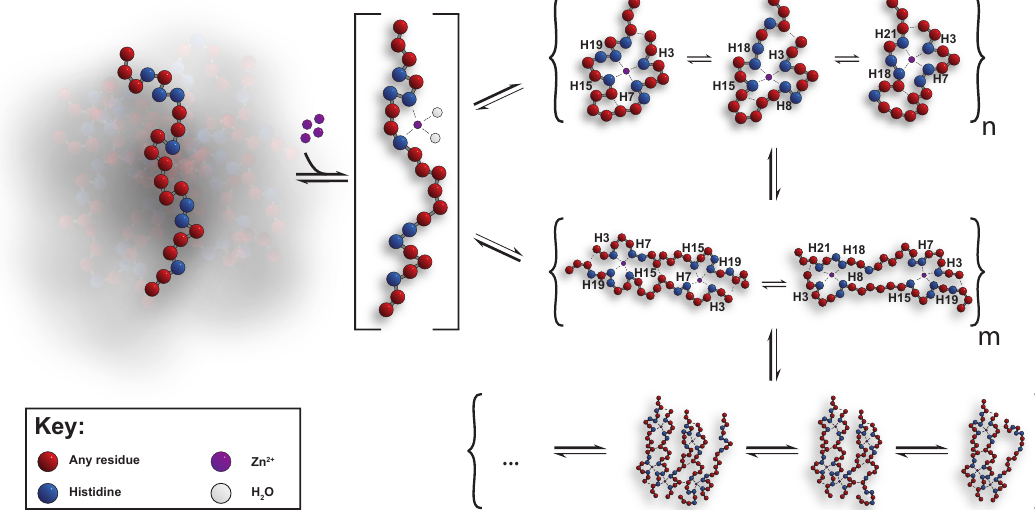
Figure 11. Schematic depiction of the mechanism of Zn 2+ induced oligomerisation of Hst5. By entropic reasons, one can expect that it is the middle region of Hst5 that constitutes the preferred seed, since it will be more favourable for the system if the peptide ends remain